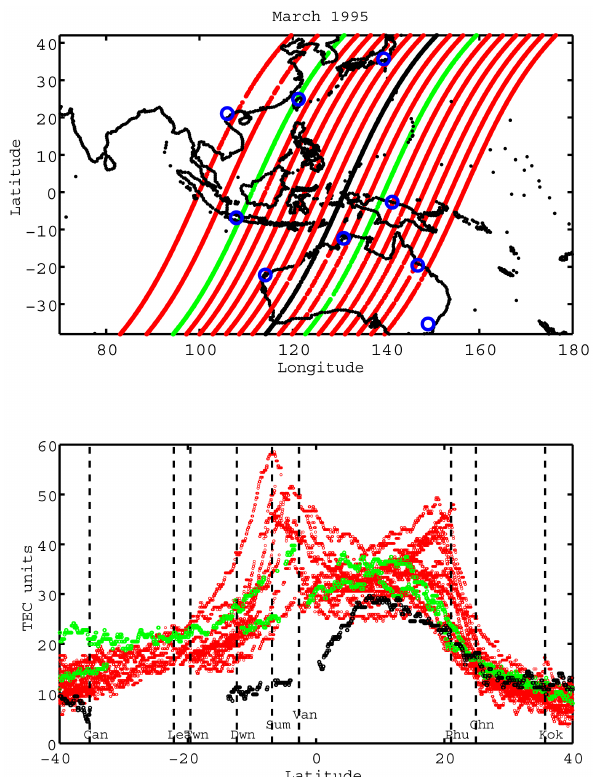
Fig. 4. TOPEX/Poseidon passes and corresponding TEC values observed between 16:30–14:05 LT over the period 24 March to 3 April 1995. The ionospheric negative storm day TOPEX pass on 27 March is shown in black and passes on the preceding day, 26 March, in green.